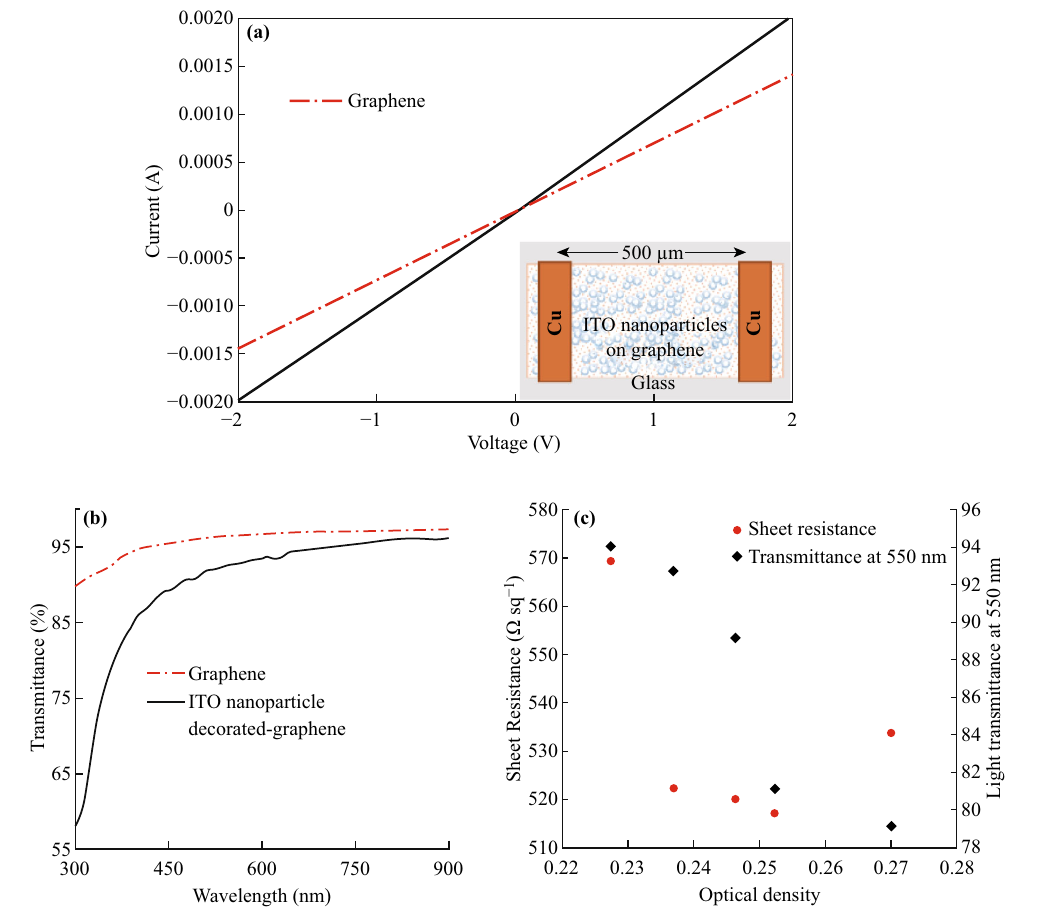
Fig. 6 a Voltage–current ( V – I ) characteristics of graphene and ITO nanoparticles-deposited graphene (inset image shows the schematic diagram of the prepared sample). b UV–Vis spectrum of graphene and ITO nanoparticle-deposited graphene. c Variation in sheet resistance and light transmittance as functions of optical